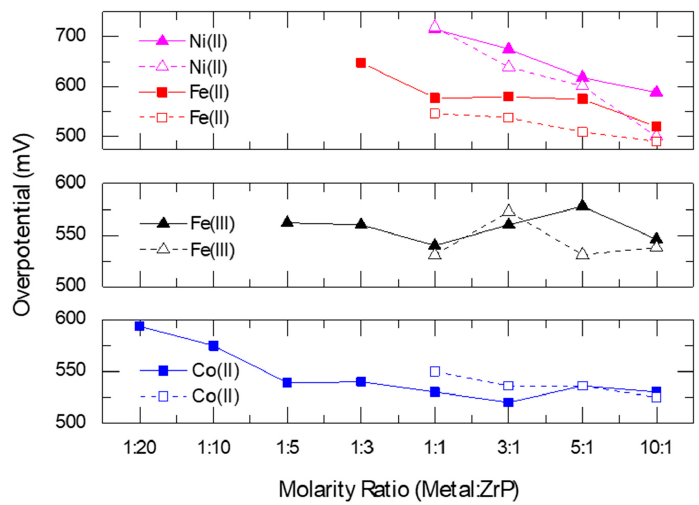
Figure 9. Overpotential as a function of M:ZrP synthesis ratio for the different metal-modified ZrP catalysts. Dashed lines correspond to surface-adsorbed catalysts while the solid line correspond to metal-intercalated catalysts. Taken from reference [87].